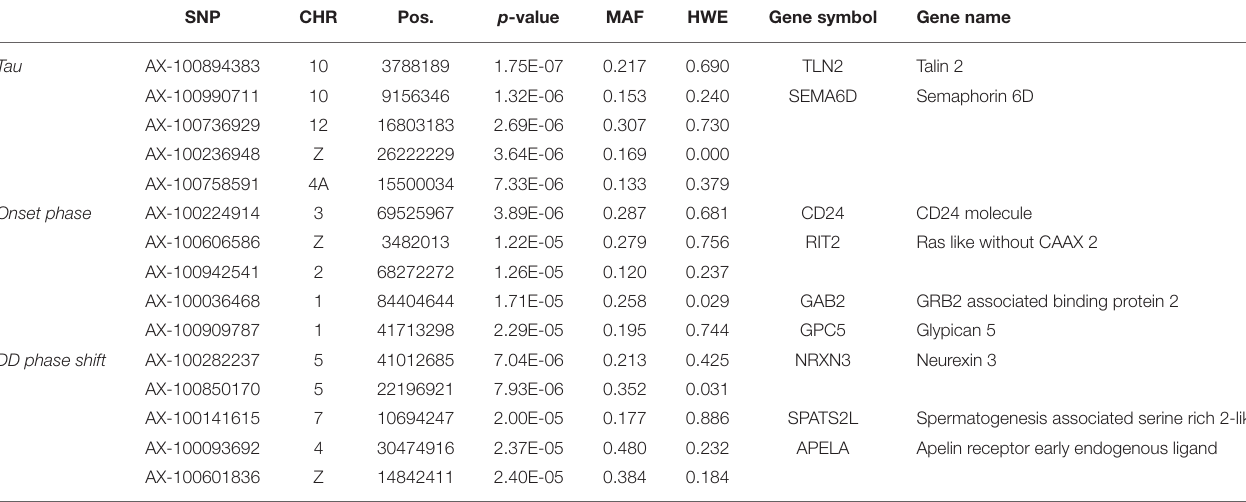
TABLE 3 | The five most significant SNPs per trait for genome-wide association analyses testing for an interaction between SNP effects and activity traits, ordered by significance. SNP CHR